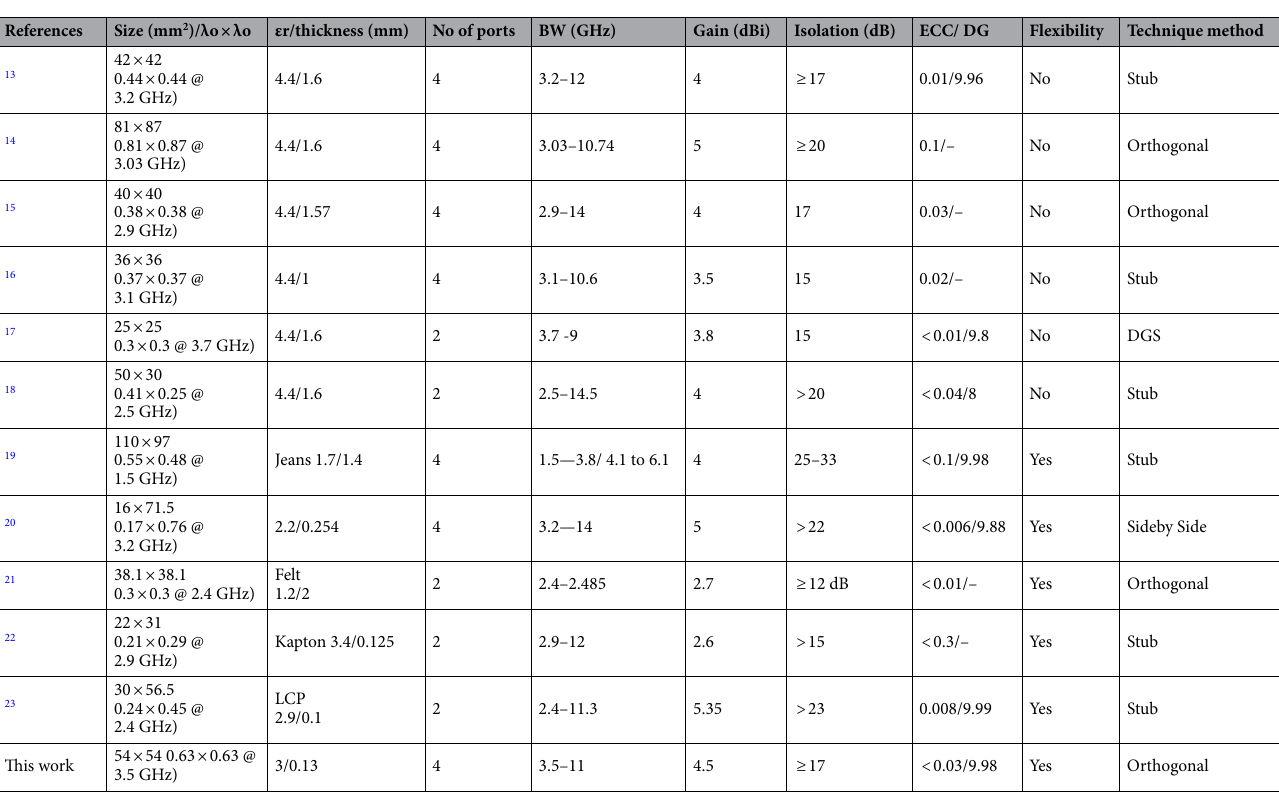
Table 2. The flexible MIMO antenna in comparison with other flexible and rigid